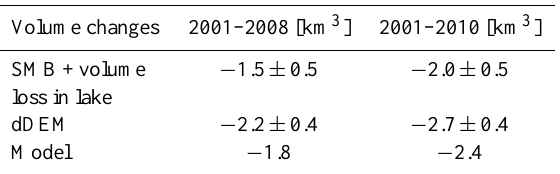
Table 5. Ice equivalent volume changes for two periods (2001– 2008 and 2001–2010) estimated from observed surface mass bal- ance and volume loss in the frontal lake, from the difference in the measured DEMs and simulated with the coupled surface mass balance-ice flow